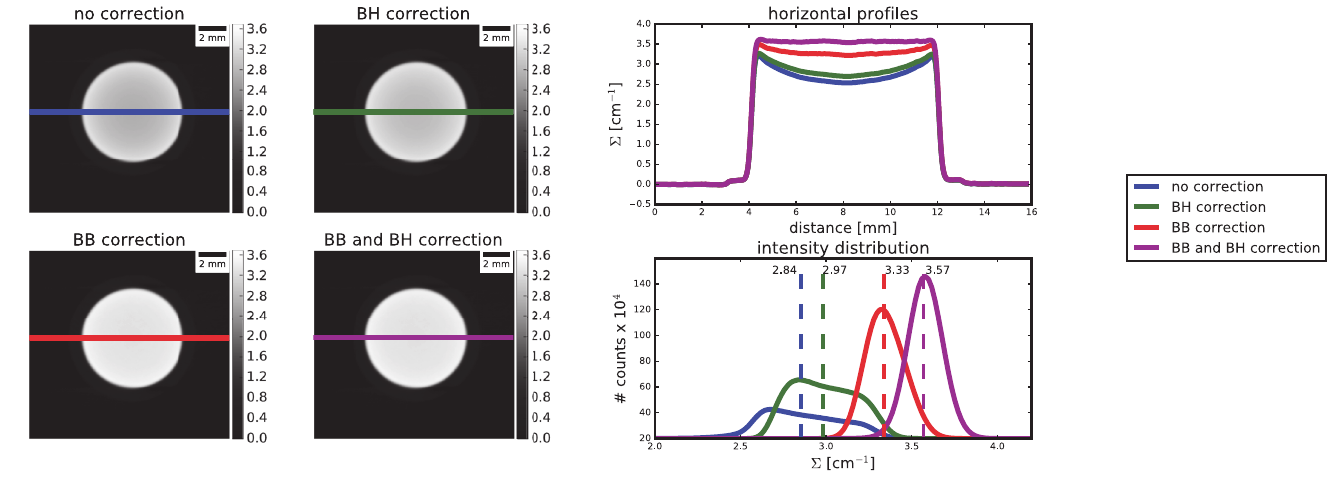
Fig 4. Results on the water sample: combined effect of BB correction and BH correction on the computed attenuation coefficients.